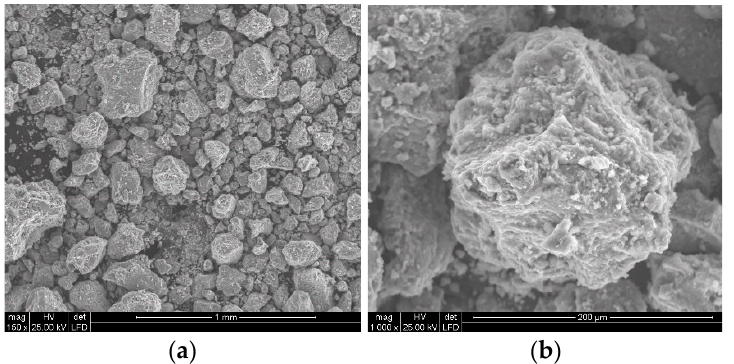
Figure 13. Example SEM images of particles of concretions comminuted in a waterjet mill (for d w = 0.7 mm, d h = 2.4 mm, s = 10 mm, p = 100 MPa): ( a ) general view, ( b ) surface development.